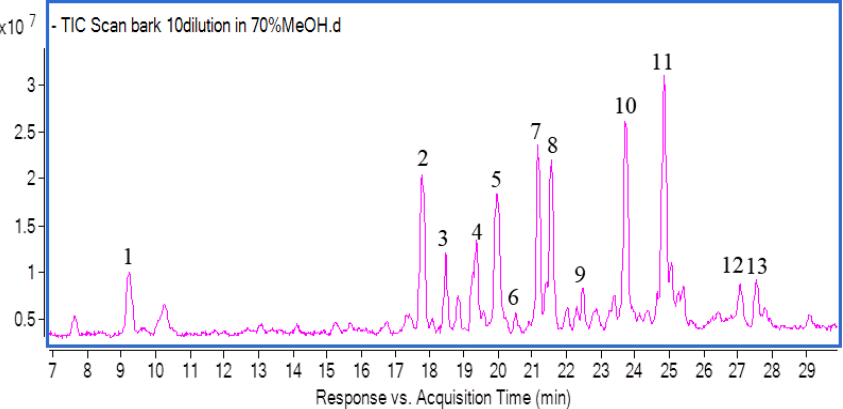
Figure 2. Total ion chromatograms of 70% MeOH extract of MT twig by HPLC-QTOF-MS. Peak